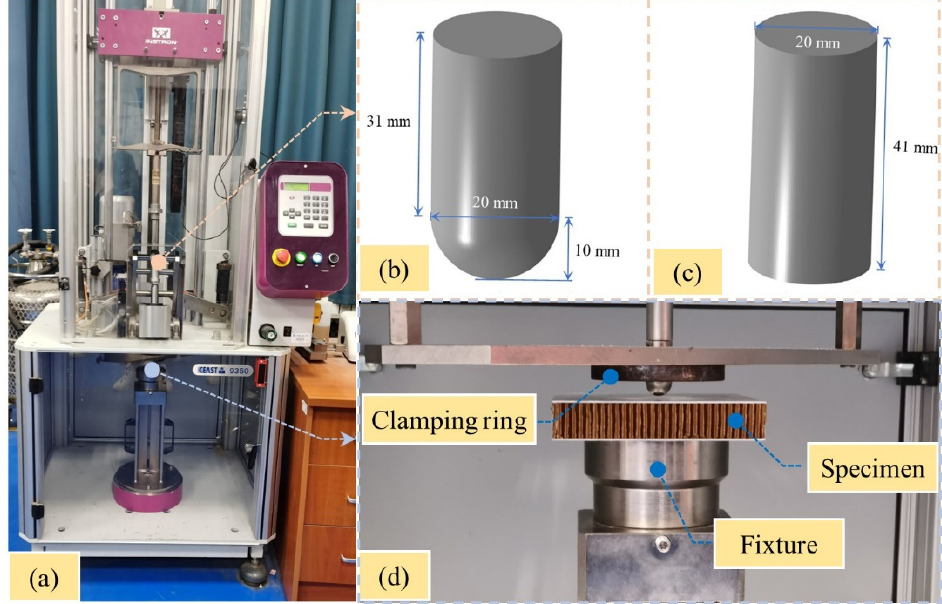
Figure 4. Low-velocity-impact device. (a) Instron CEAST 9350. (b) Hemisphere impactor. (c) Flat impactor. (d) Clamping system. impactor. ( d ) Clamping